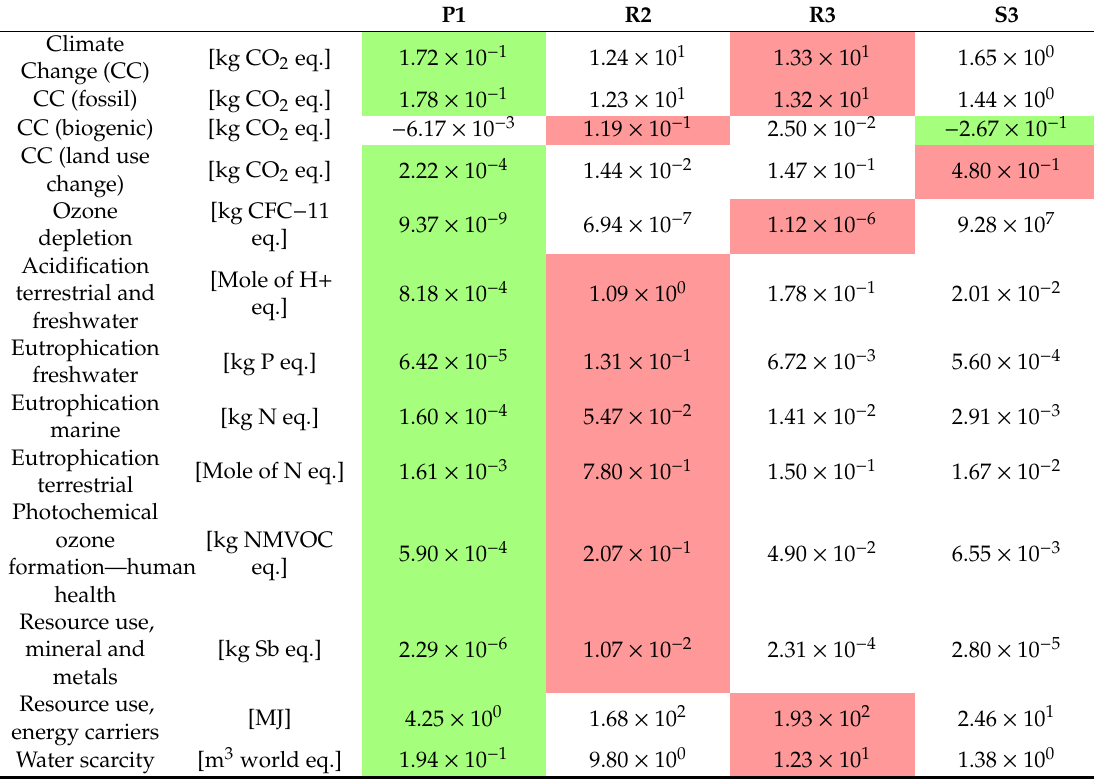
Table 4. Total environmental impacts of the compared absorbers (per 1 m 2 ) in categories defined by EN 15804. Red indicates the highest, and green the lowest value in each impact category. P1